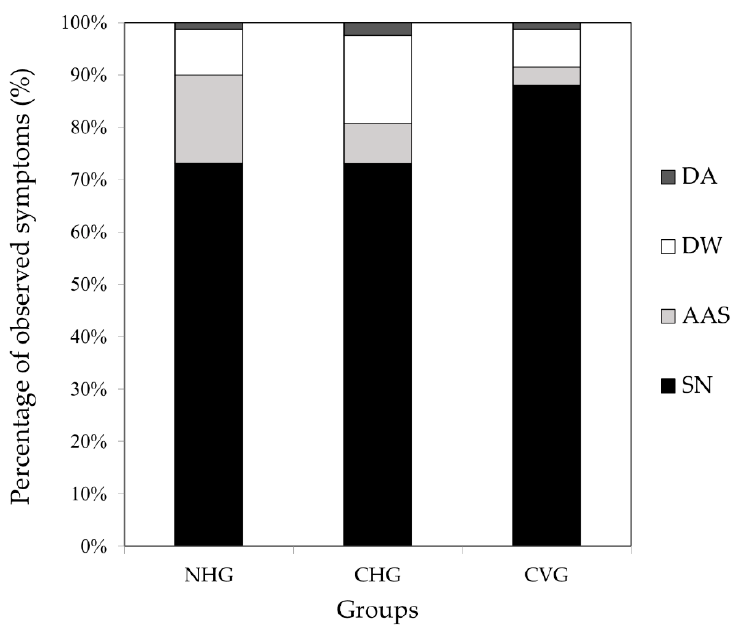
Figure 5. Percentage of observed symptoms of emerged bees. SN: survived and successfully eclosed